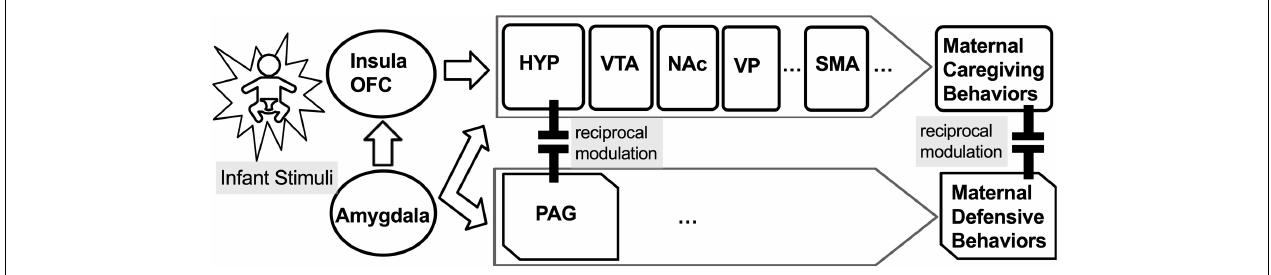
FIGURE 1 | The maternal behavior neurocircuit (MBN) is comprised of two reciprocally inhibiting subsystems for: (1) maternal care, mediated by the medial preoptic area (mPOA) of hypothalamus (HYP), ventral tegmental area (VTA), nucleus accumbens (NAc), and ventral pallidum (VP), which is functionally connected to the supplementary motor area (SMA), and (2) maternal defense, mediated by periaqueductal gray (PAG). These opposing subsystems are regulated by the amygdala (AMY), insula, and orbitofrontal cortex